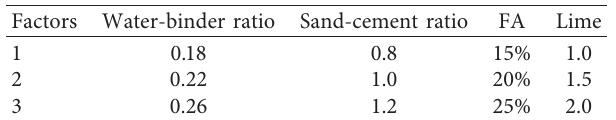
Table 6: Orthogonal test factors and